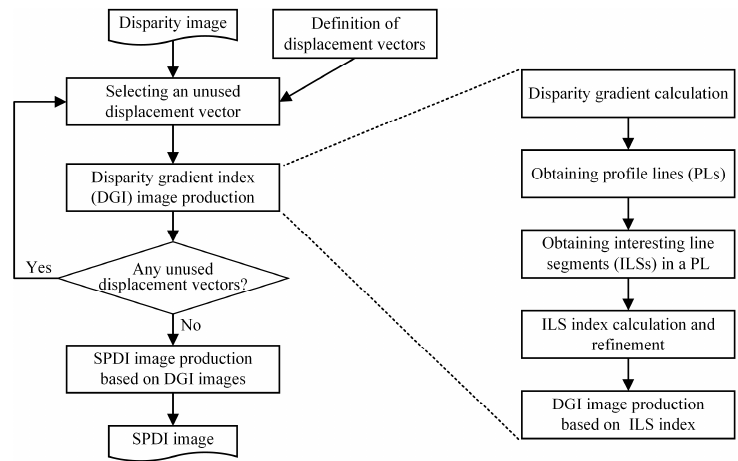
Figure 2. Flowchart of stereo pair disparity index (SPDI) image production.